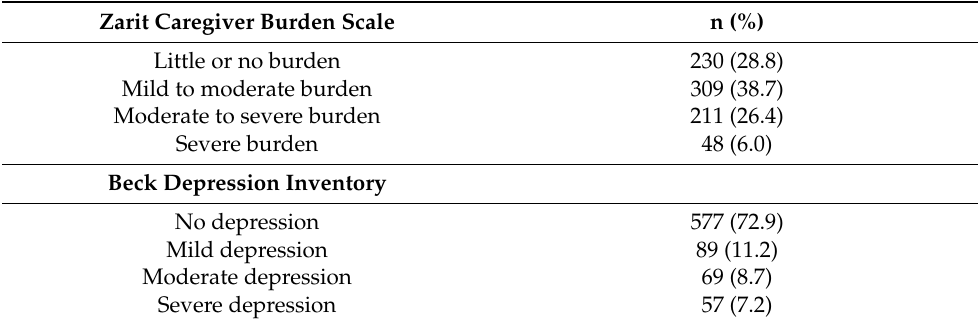
Table 3. Zarit Caregiver Burden Scale and Beck Depression Inventory.